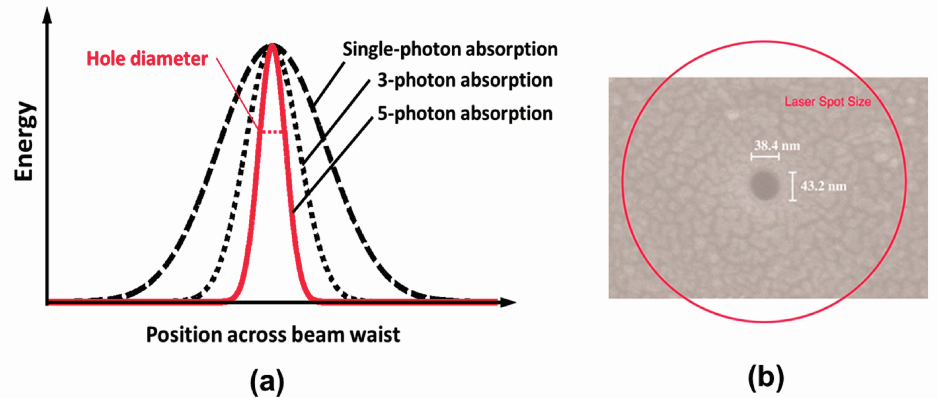
Figure 4. ( a ) Profiles of energy absorbed during single-photon absorption (black dashed line), 3-photon absorption (black dotted line) and 5-photon absorption (red solid line). The hole diameter is indicated by the red dashed line; ( b ) SEM micrograph of nanometer-scale hole fabricated in glass. The red circle indicates the 1/e 2 focus-spot size [19] (Reproduced with permission from PNAS. ©2004 by the National Academy of Sciences, Washington, DC,